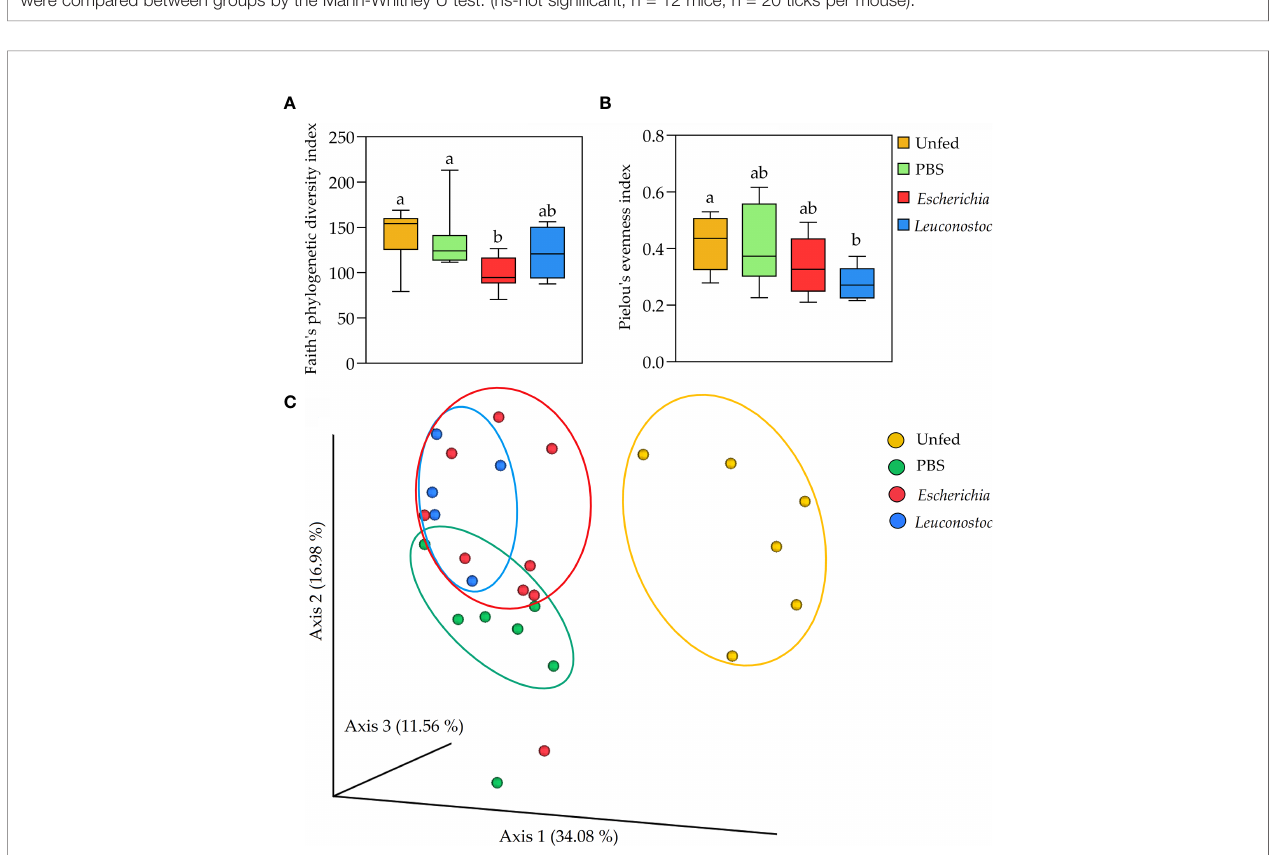
FIGURE 3 | Impact of anti-microbiota vaccines on tick microbial diversity and evenness. (A) Faith ’ s phylogenetic diversity and (B) Pielou ’ s evenness indexes were used to calculated the microbial richness and evenness, respectively, of the bacterial communities of unfed ticks and ticks fed on mock-immunized (green, PBS), E . coli -immunized (red) and L. mesenteroides -immunized (blue) mice. Different letters ( ‘ a ’ , ‘ b ’ ) denote statistical differences between groups. (C) First axis PCoA plot showing the variance of taxonomical pro fi le (Bry Curtis distance) at the level of ASVs between samples according to tick feeding status and feeding on immunized mice (PERMANOVA, p = 0.00), arbitrary ellipses were drawn to facilitate the interpretation of the fi gure. The alpha diversity indexes were calculated using 16S rRNA sequences obtained from samples of unfed I . ricinus nymphs (n = 6 tick pools), and nymphs engorged on E. coli -immunized (n = 9 tick pools), L. mesenteroides - immunized (n = 5 tick pools), or mock-immunized (n = 7 tick pools) points ( Figure 1 ) and compared mouse gut microbiota before (d0) and after (d30 and d46) vaccination in the E. coli - immunized and mock-immunized mice. Results showed non- signi fi cant differences in the microbial richness ( p > 0.05)